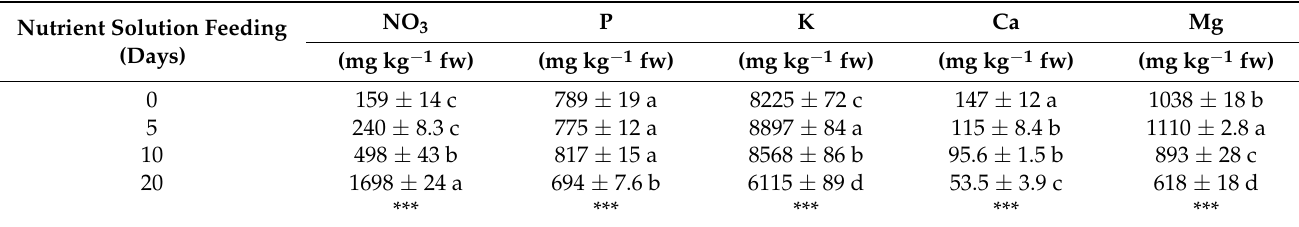
Table 2. Nitrate and mineral concentrations (mg kg − 1 fw) in relation to nutrient solution feeding regime. Nutrient Solution